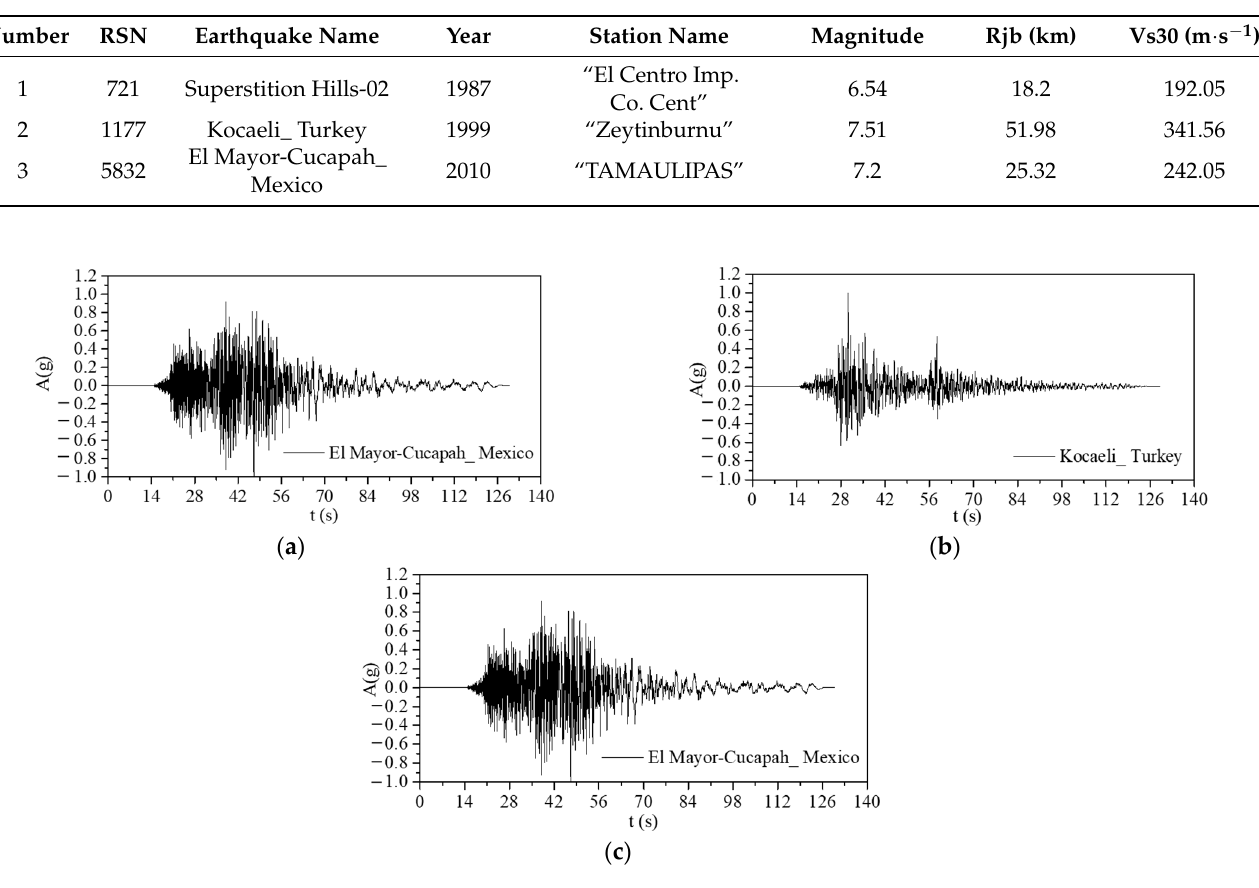
Figure 16. Three seismic wave acceleration time history curves. ( a ) Superstition Hills-02; ( b ) Kocaeli_Turkey; ( c ) E1 Mayor_Cucapah_Mexico. Table 7. Seismic wave recording information .